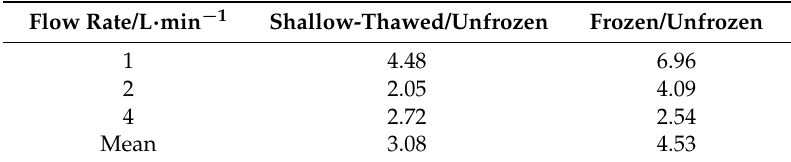
Table 1. The ratio of the soil erosion rates at the same flow rate on different slopes versus the unfrozen slope.